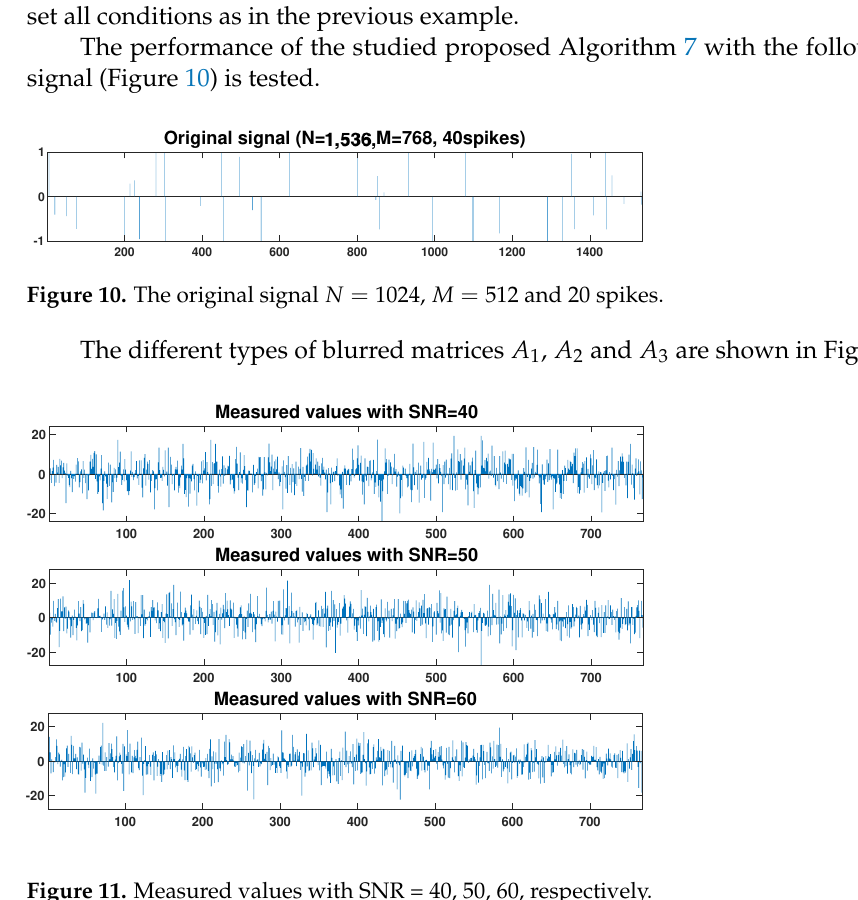
Figure 11. Measured values with SNR = 40, 50, 60,